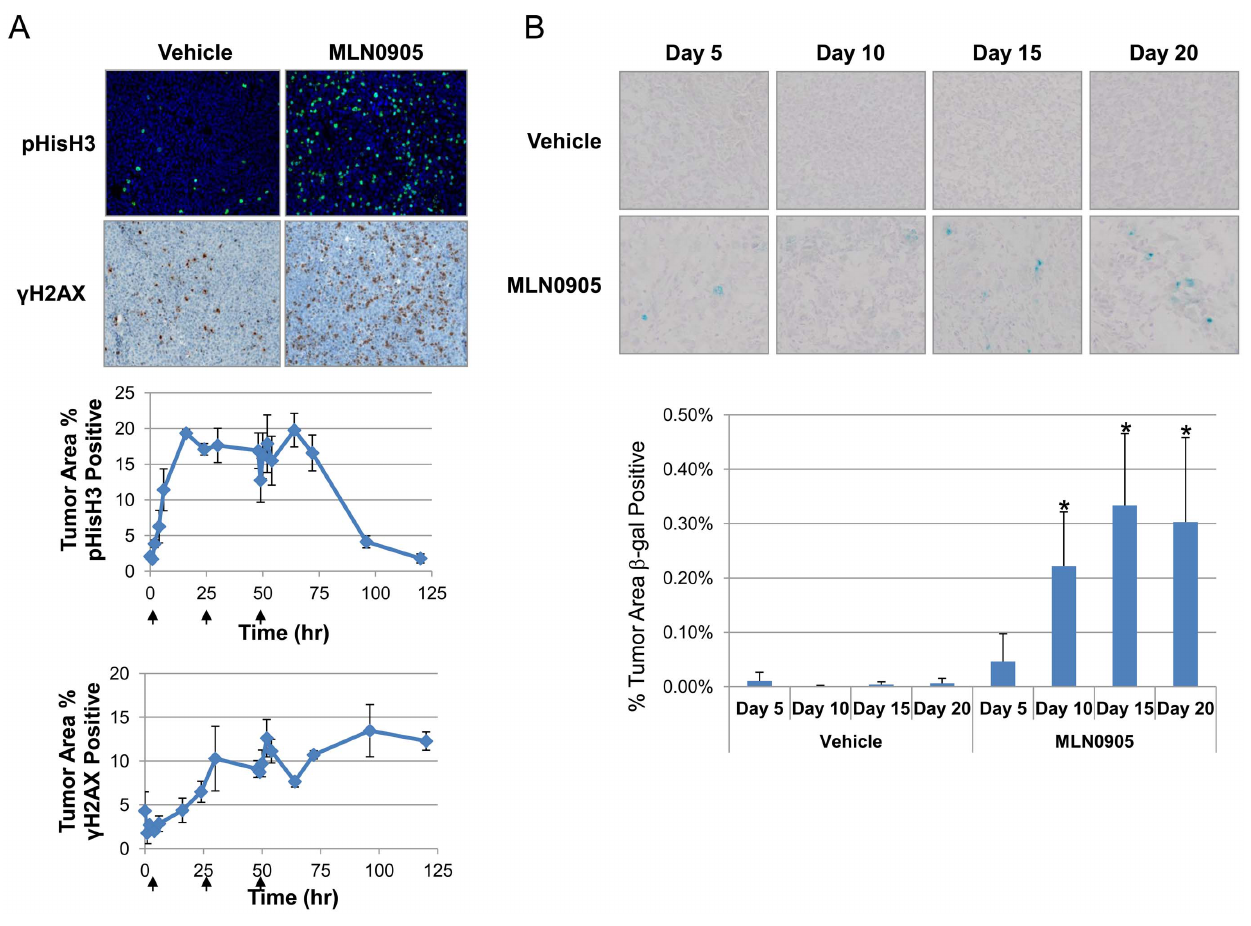
Figure 6. Invivo , Plk1 inhibition leads to mitotic arrest, DNA damage and senescence. A) HCT116 tumor bearing mice were dosed orally once a day with 23.3 mg/kg of MLN0905. Tumor tissues were harvested and stained for pHisH3 (green staining) and c H2AX (brown staining). Representative tumor sections are shown with either vehicle or MLN0905 treatment 24 hours after the first dose. pHisH3 and c H2AX signals were quantified (see graph, shown is mean 6 SD) and arrows indicate when doses were delivered. B) Tumor tissues were harvested at the indicated times and stained for b -galactosidase activity. Images shown indicate b -galactosidase staining in the MLN0905 treated tumors but not in the time-matched vehicle controls. Staining was quantified and is represented as % tumor area positive (see graph, shown is mean 6 SD; *p # 0.04, two-tailed paired t- test).